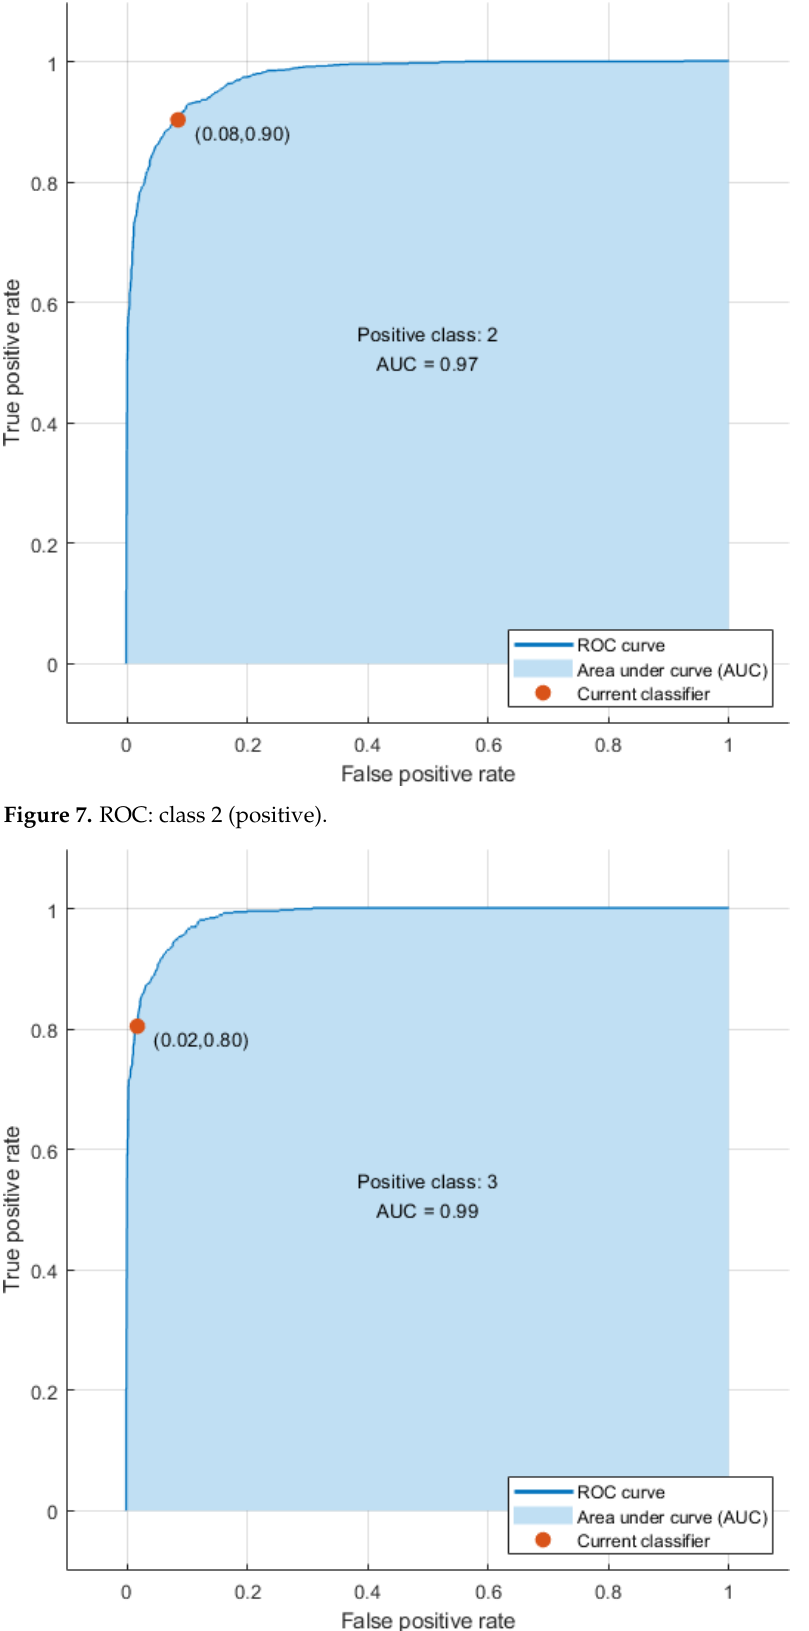
Figure 8. ROC: class 3